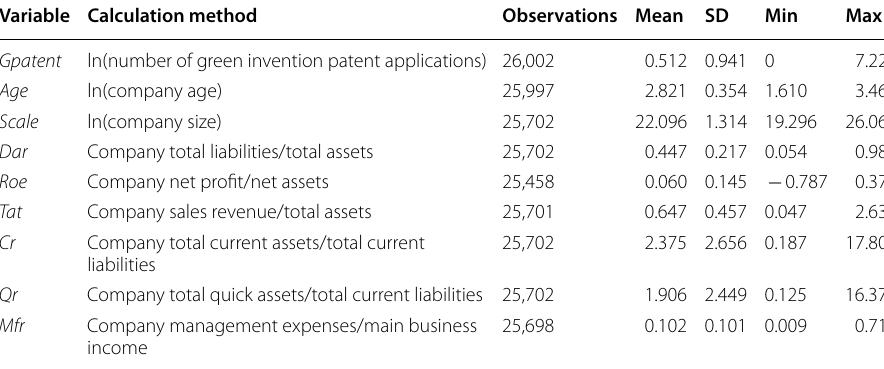
Table 2 Calculation methods and descriptive statistics of variables Variable Calculation